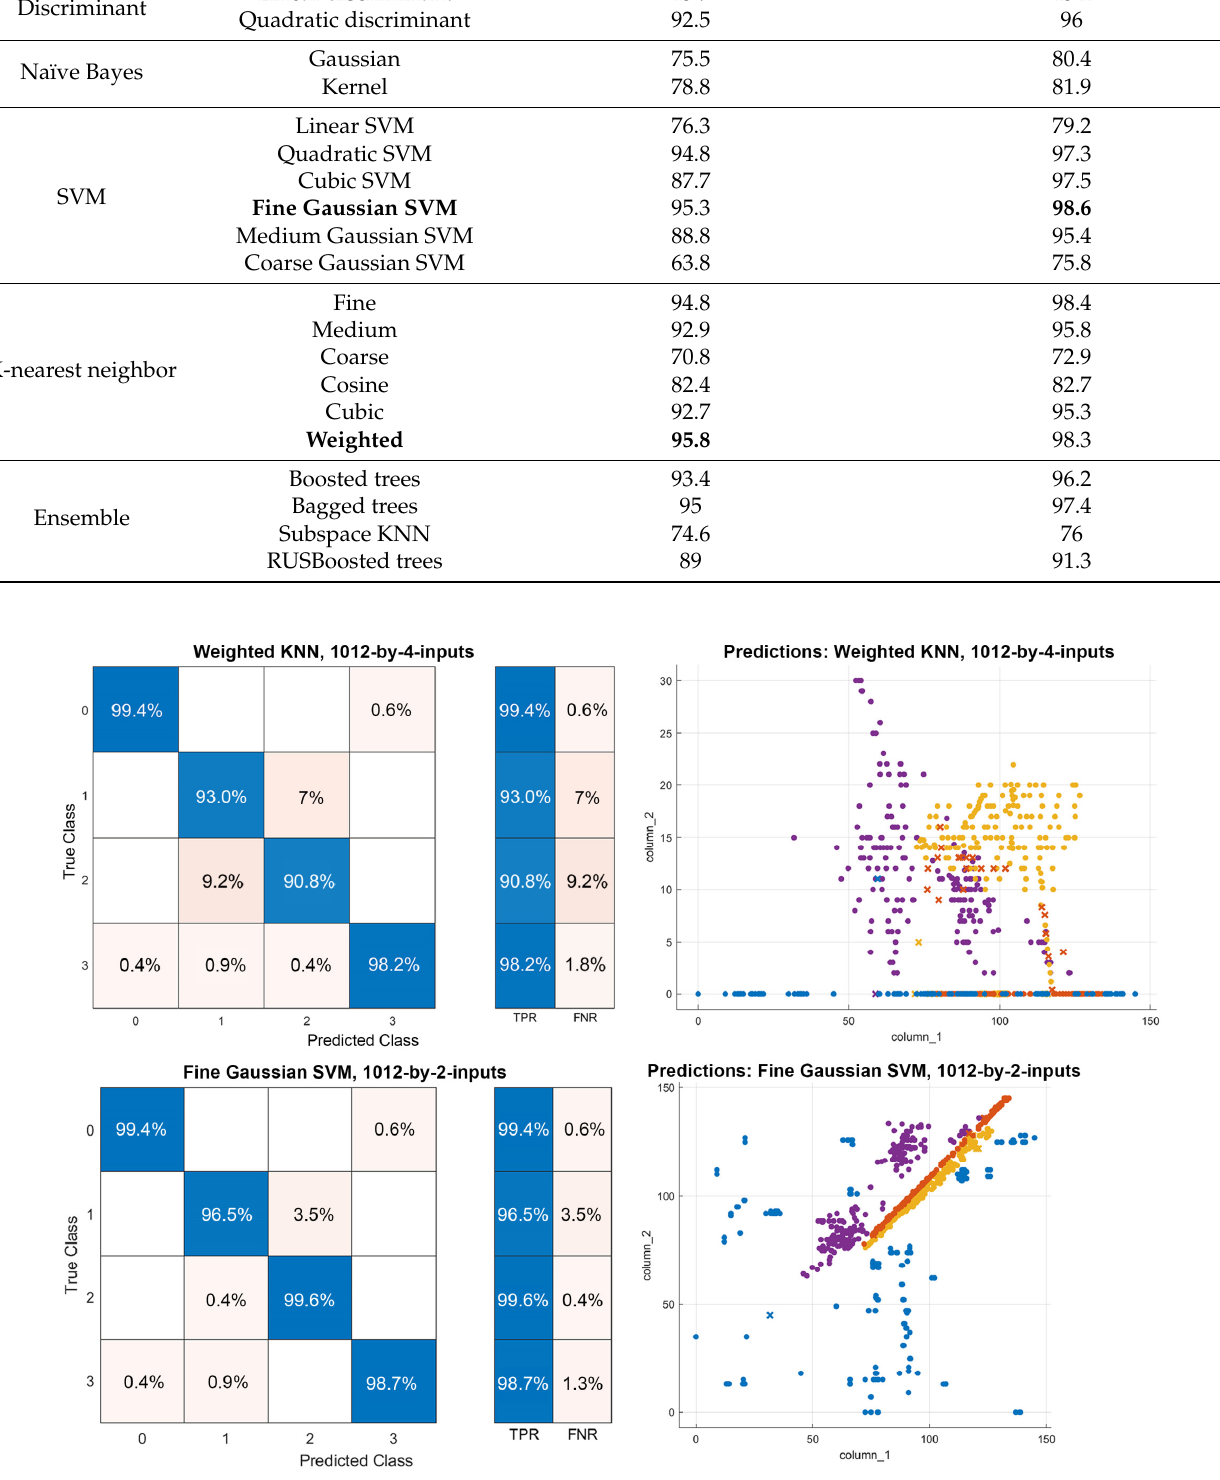
Figure 7. Exemplar confusion matrices and prediction plots for classification